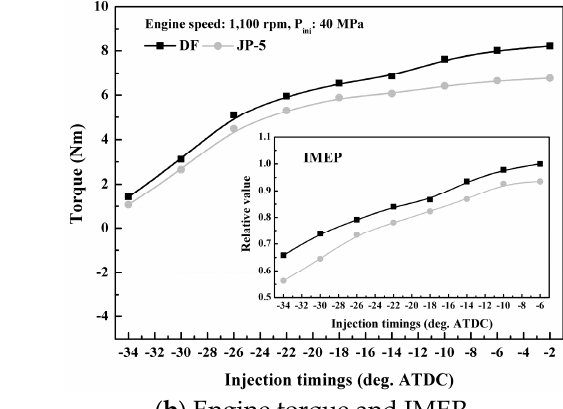
Figure 5. Max. in-cylinder pressure, ROHR, and ROPR characteristics with injection timings .